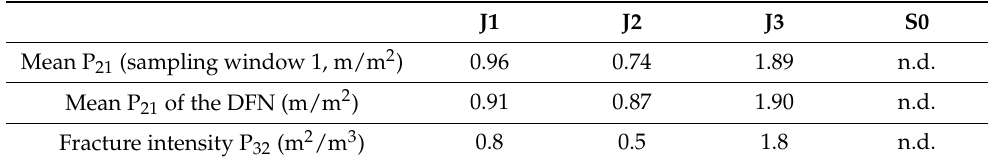
Table 3. Fracture intensity analysis from the sampling windows and DFN model. n.d. = not detected. J1 J2 Mean P 21 (sampling window 1, m/m 2